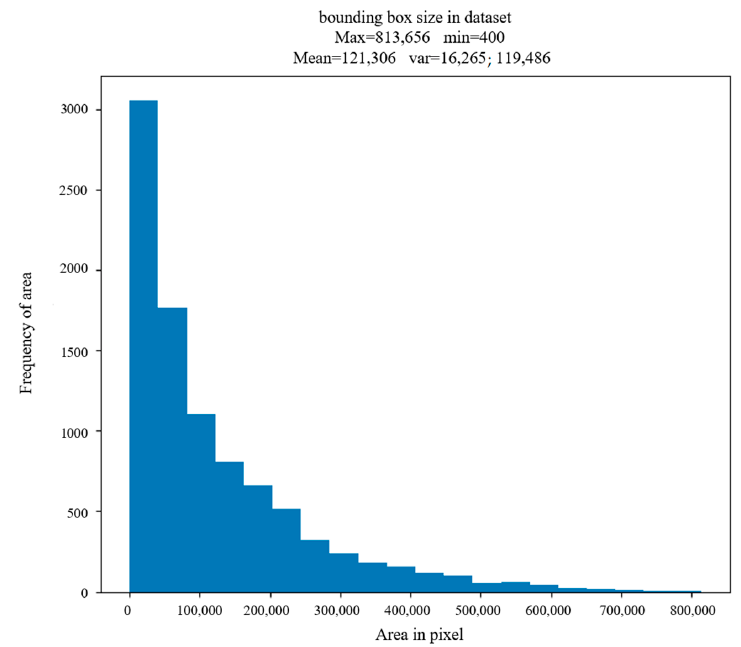
Figure 6. Partial SeaShips Dataset.